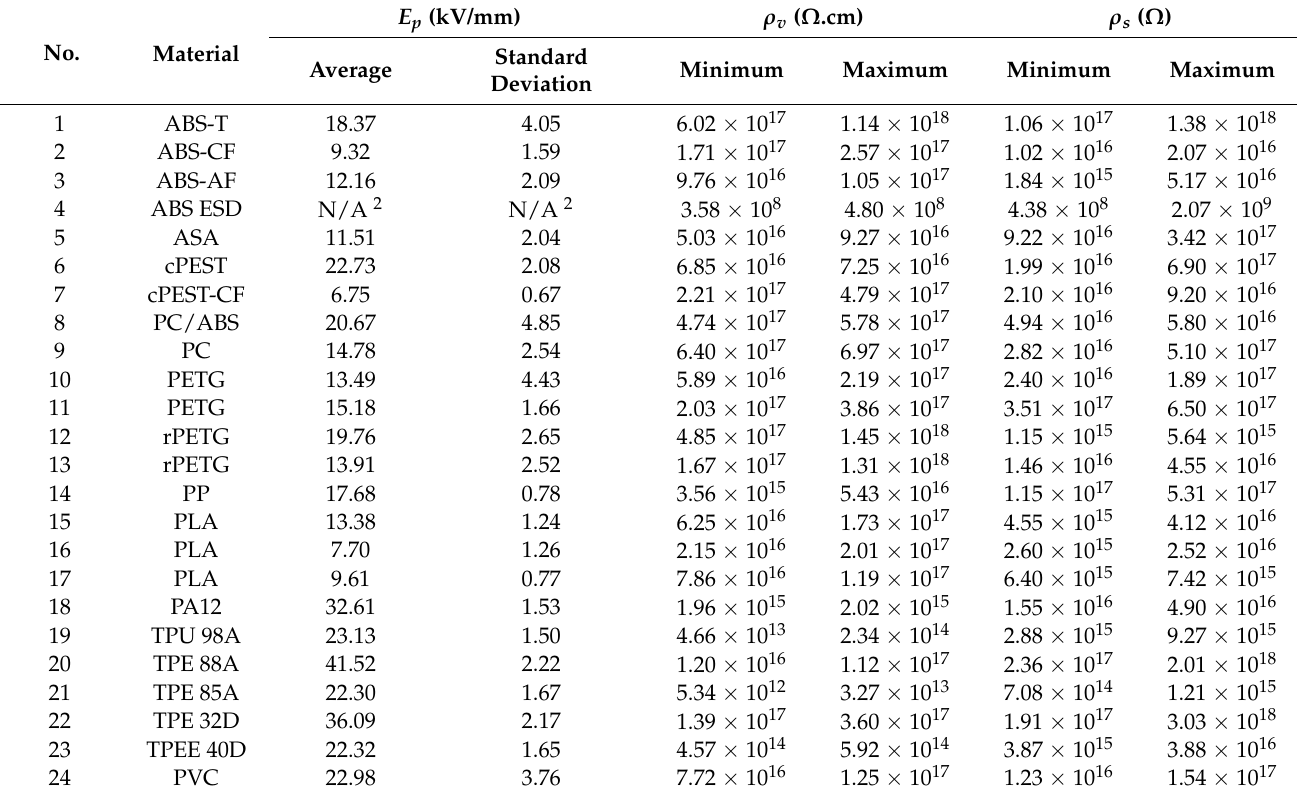
Table 3. Summary of the dielectric properties of the tested 3D printed materials of DSC and STA results.